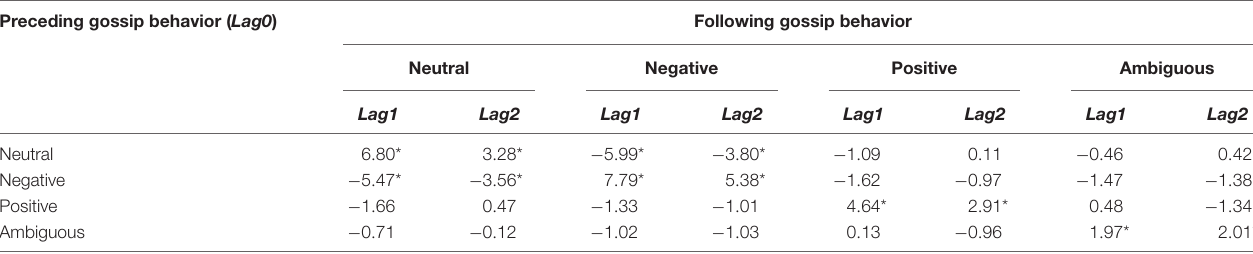
TABLE 3 | Z -values of conditional probabilities of gossip behavior sequences at lag1 and lag2. Preceding gossip behavior ( Lag0